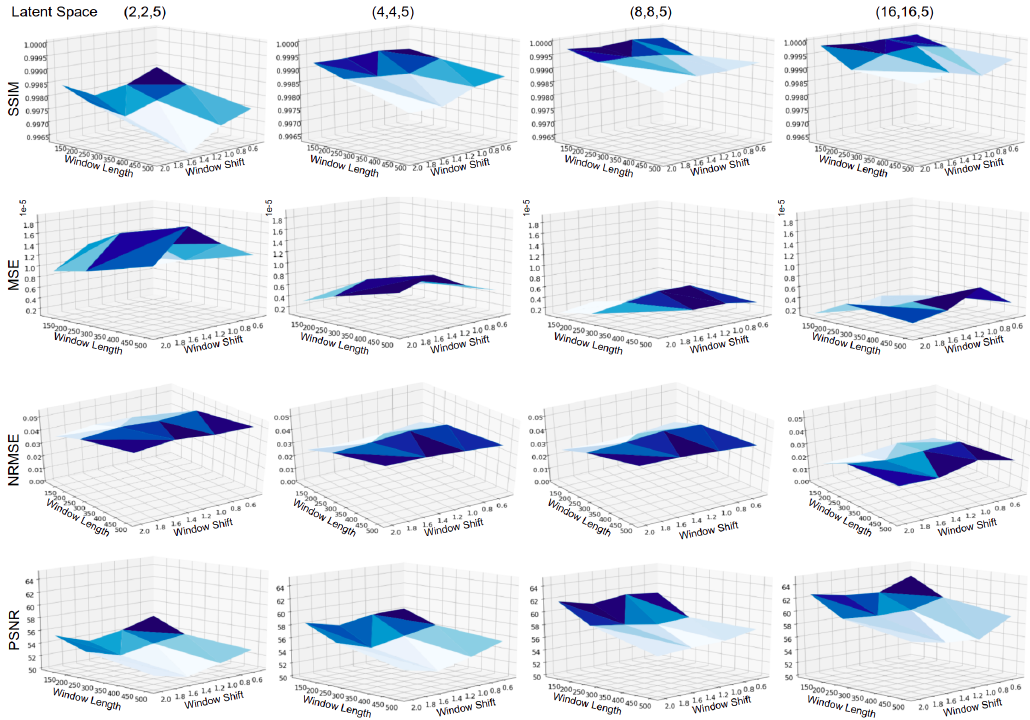
Figure 5. 3D plot depicting mean reconstruction scores (SSIM, MSE, NRMSE, and PSNR) for 48 dif- ferent ConvAE models with varying window length (WL), window shift (WS), and latent space